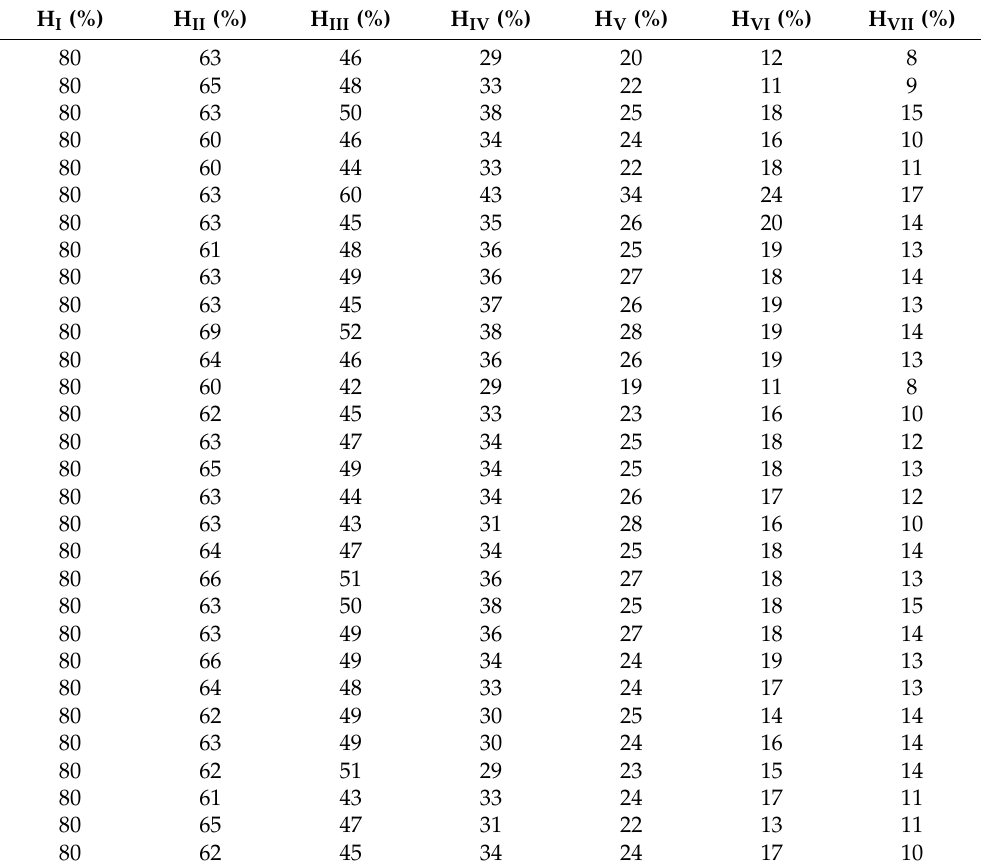
Table A2. The results of ultrasonic measurements used to determine the attenuation in samples produced using standard technology.